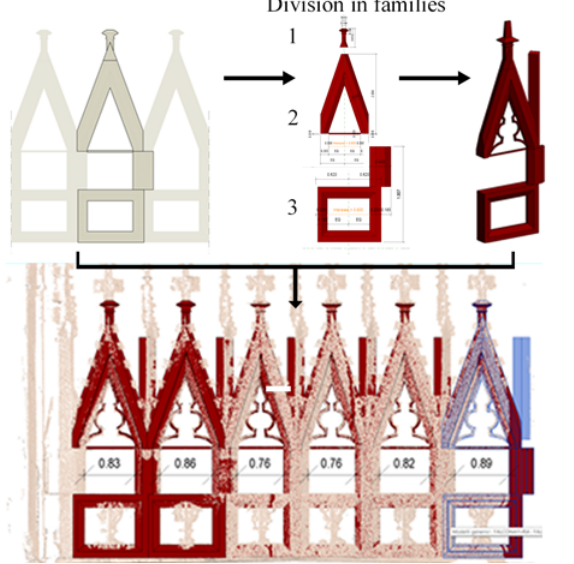
Figure 10. Parametrization workflow in Revit 2016: once modelled one falconatura divided in three families, the others were adjusted locking some parameters and varying